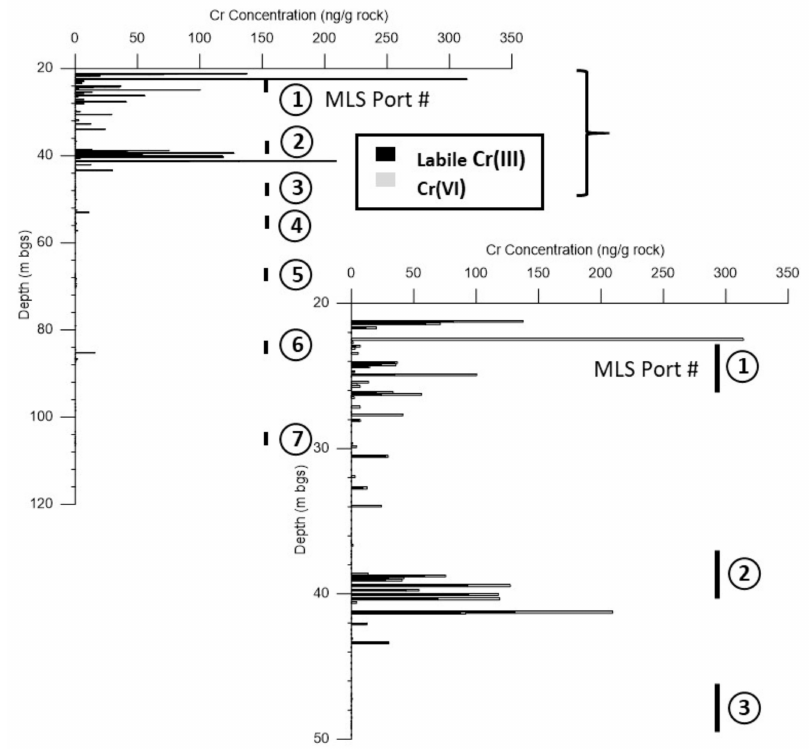
Figure 8. Stacked bars showing background-corrected rock core data for extractable Cr ( VI ) and labile Cr(III) for core samples from EPA-21BR, with the grey bars representing concentration of mobile Cr ( VI ) and black bars representing labile Cr(III) that formed precipitates in the rock matrix [33]. MLS port intervals are also shown for reference. Adapted from Chemical Geology, 474, Zhao et al., Determination of Cr(III) solids formed by reduction of Cr(VI) in a contaminated fractured bedrock aquifer: